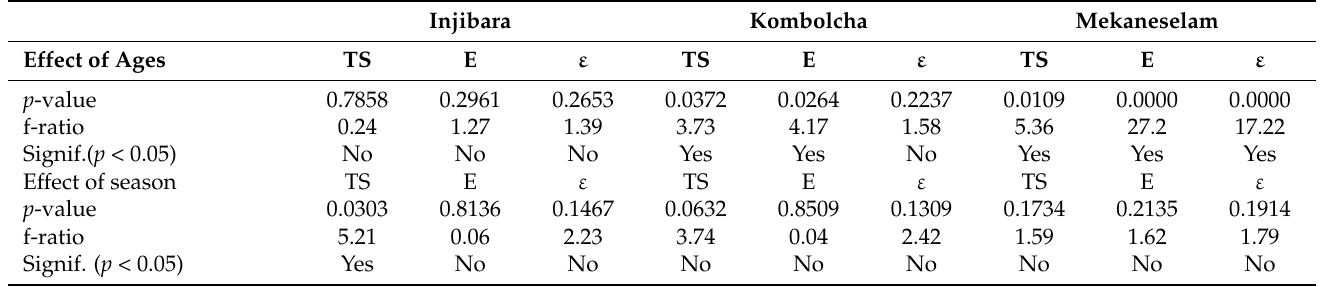
Table 3. ANOVA test results of tensile test on the effect of ages and harvesting seasons. Injibara